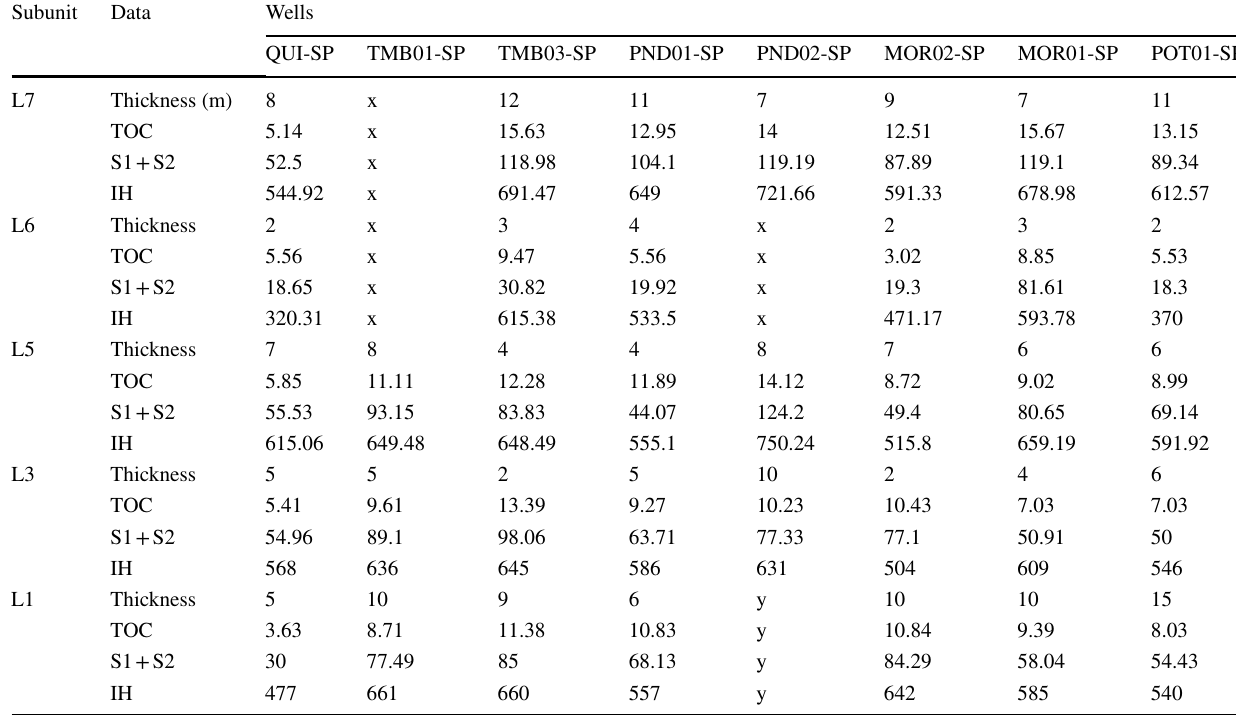
Table 2 Thicknesses of chemostratigraphic subunits L1, L3, L5, L6 and L7, and respective average values of TOC (in %), yield (S1 + S2 in mg HC/g rock) and HI (in mg HC/g TOC). x—absent units. y—well did not completely penetrate the unit